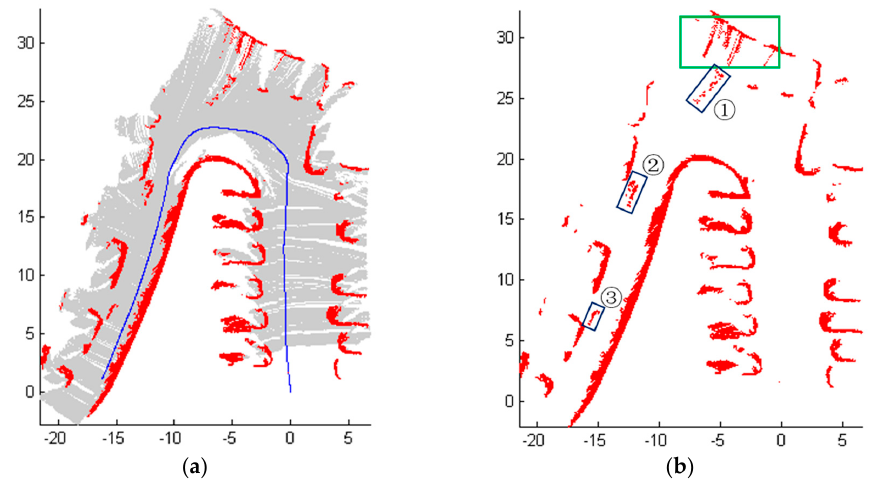
Figure 11. The detection results of Scene 3 with the joint using of the estimated height and the estimated vector. ( a ) Results of obstacles detection; ( b ) The position of some passerby obstacle areas.